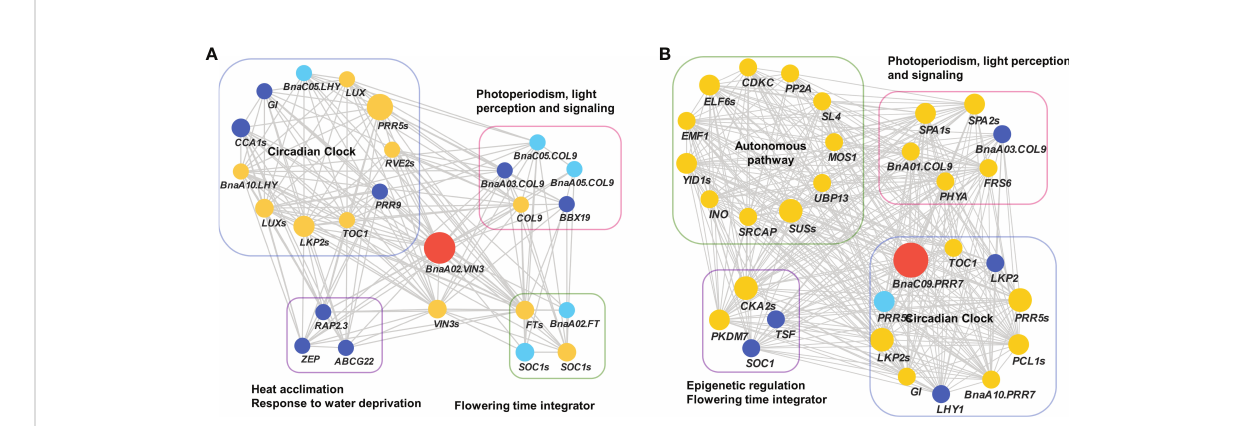
FIGURE 5 Co-expression network of BnaVIN3 and BnaPRR7 with co-expressed genes related to fl owering time (A, B) . Light blue, dark blue, and yellow node indicate co-expressed genes that were detected in semi-winter, spring, and both types of oilseed rapes, respectively. The size of each node represents the number of genes in each gene